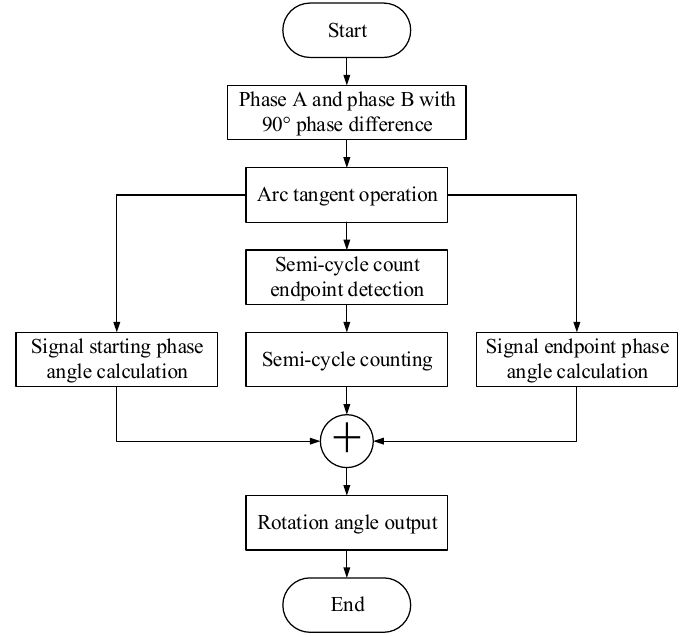
Figure 4. Technical process of the Arc Tangent Subdivision (ATS) method.